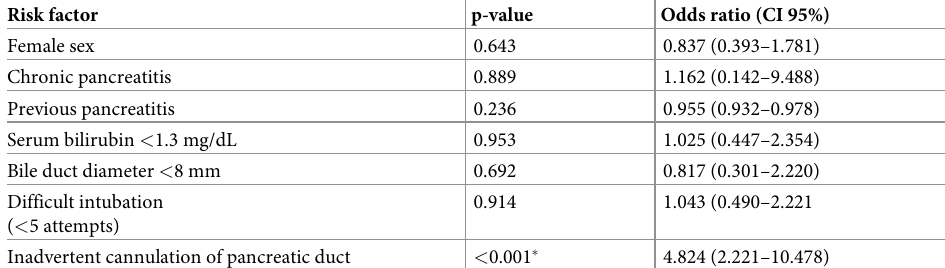
Table 5. Risk factors for PEP in patients who did not receive PEP